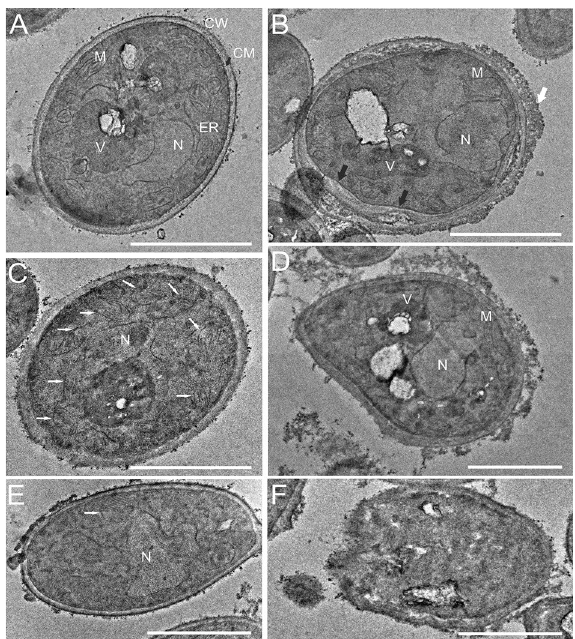
Figure 5. TEM image of ( A ) C. albicans control cell; CW cell wall, CM cytoplasmic membrane, N nucleus, M mitochondria; ER endoplasmic reticulum, V vacuole; ( B – F ) C. albicans cells after incubation with AAF (100 µg mL −1 ). ( B ) a cell with shrinkage of the cytoplasmic membrane (black arrows) and accumulated substance on the cell wall (white arrows); ( C ) a small cell with enlarged mitochondria (white arrows); ( D ) a deformed cell with fuzzy internal structures, ( E ) a cell with a large, scattered nucleus and a big mitochondrion marked by a white arrow, ( F ) a cell with loss of the shape of organelles and cell wall integrity. Bars represent 2 µm.